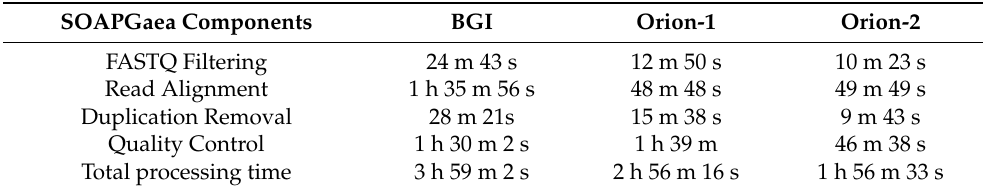
Table 2. Performance comparison of four components of SOAPGaea.